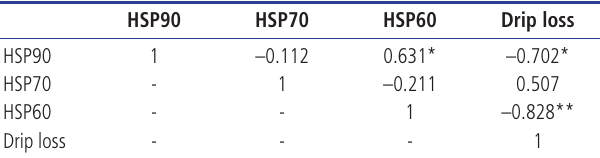
Table 2. Correlation coefficients (r) and probabilities (p) of significance